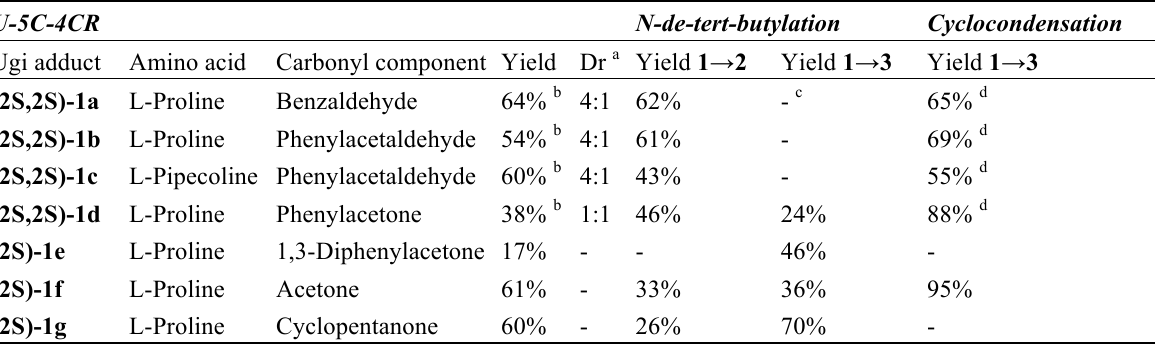
Table 1. Synthesis of compounds 1 – 3a – g